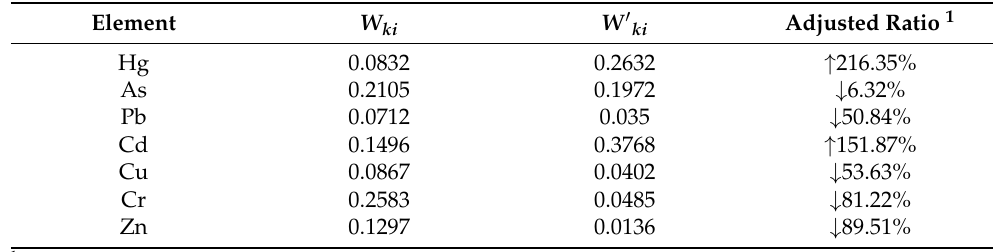
Table 3. Comparison of the mean weights of soil potential toxic elements in the study region before (W ki ) and after (W’ ki ) correction by introducing the toxic response factor.